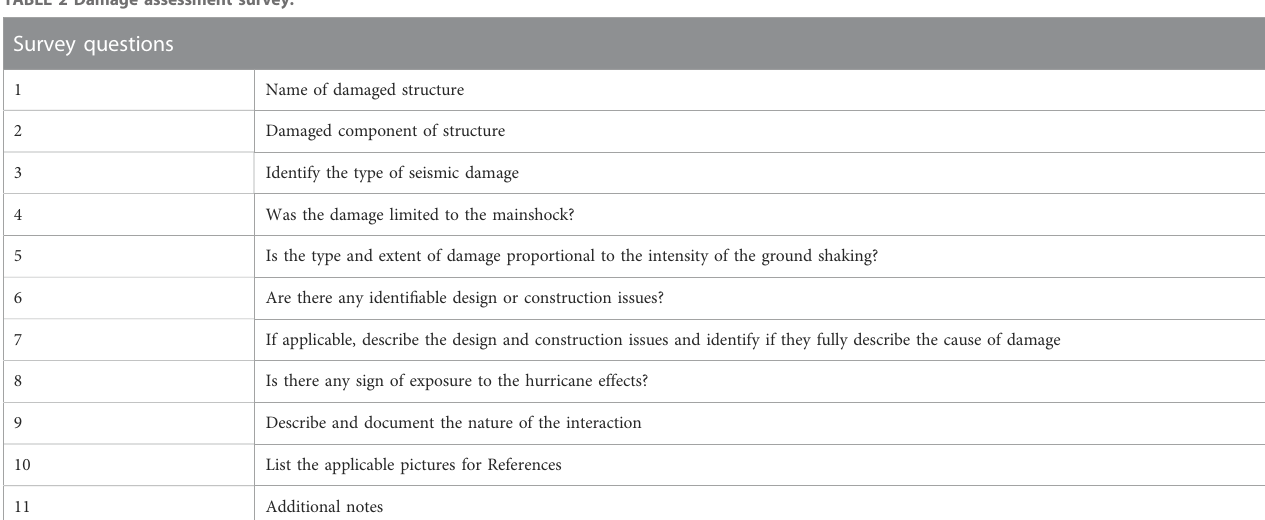
TABLE 2 Damage assessment